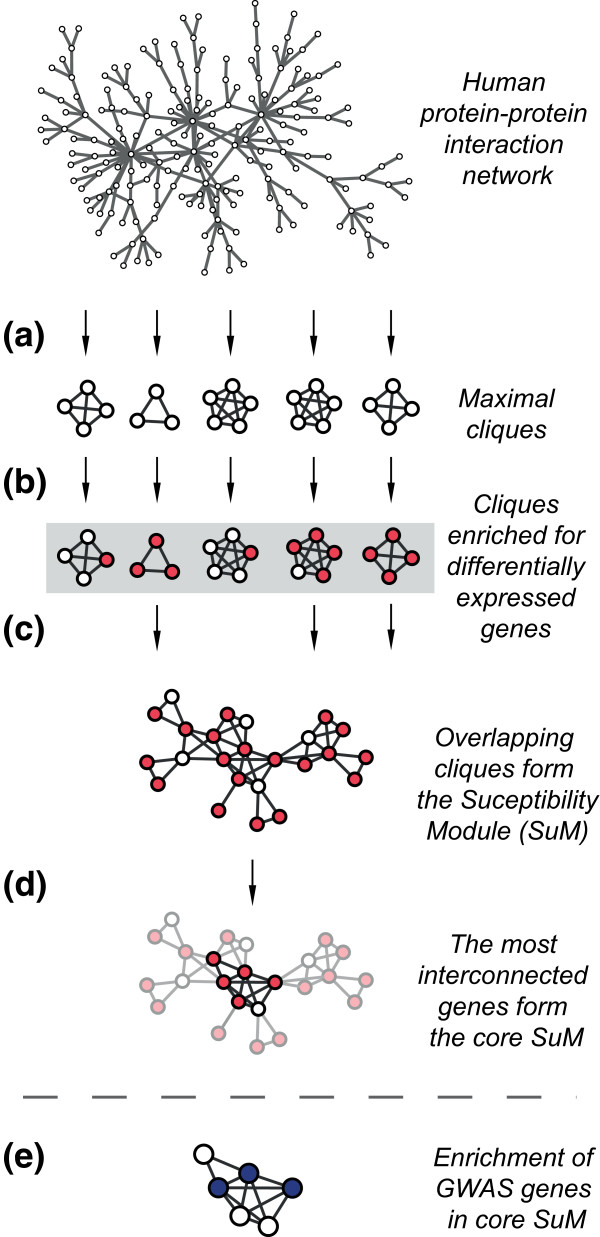
Overview of identification of susceptibility modules (SuMs). (a) Maximal cliques were obtained from a human PPI. (b) Disease-associated cliques were identified by selecting those that were enriched for differentially expressed genes. (c) Such cliques were mapped onto the PPI network, resulting in the identification of a SuM of overlapping cliques. (d) A core SuM was identified using average shortest path length. (e) This core SuM was validated by showing enrichment for GWAS genes.